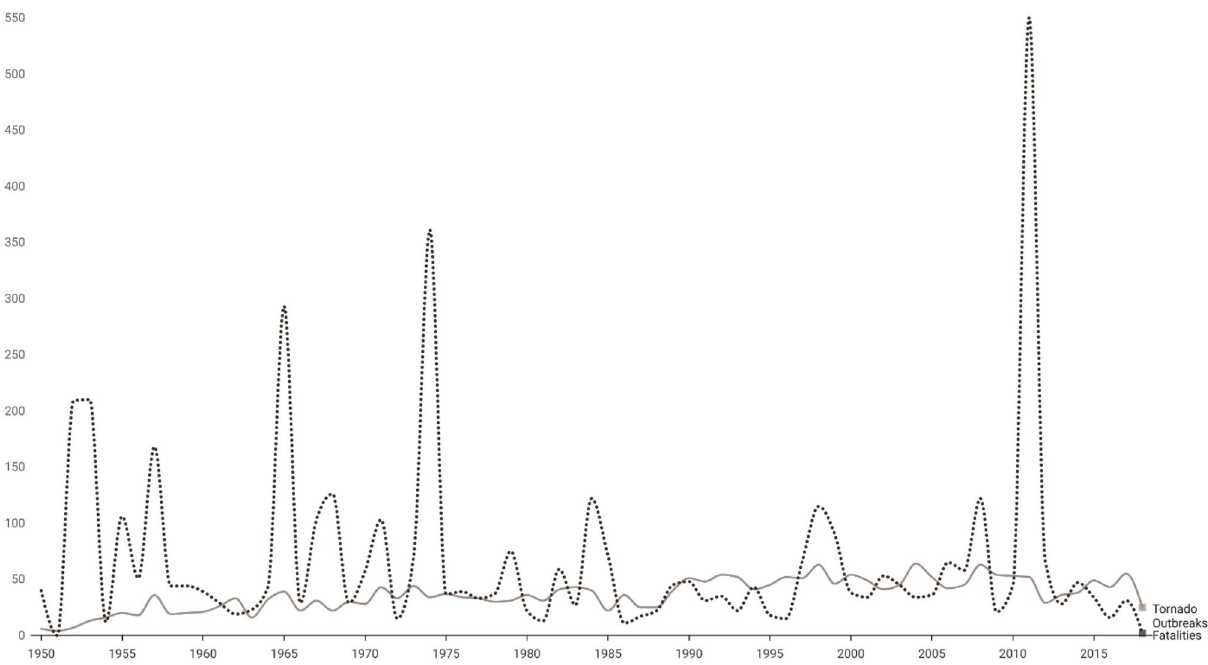
Fig. 2 Number of fatalities given the occurrence of tornado outbreaks in the United States, 1950−2018. Source Adapted from Tippett et al. (2016). Interactive version of the map is available at https:// dataw rapper. dwcdn. net/ LVD08/5/